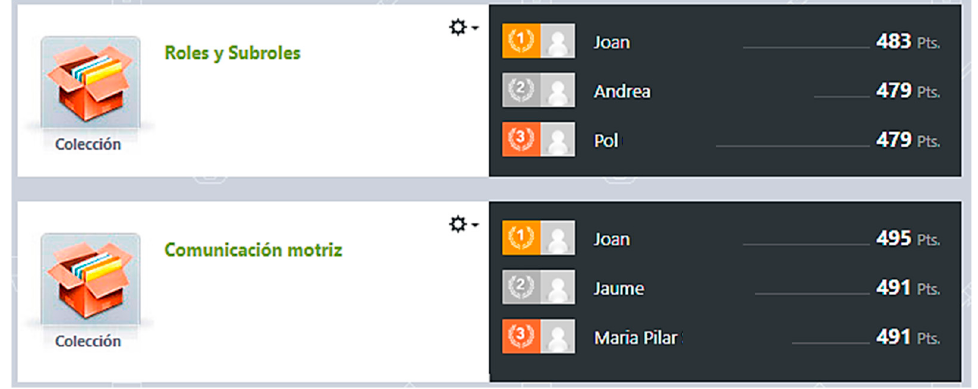
Figure 4. Competitive gamification dynamics with classification. EGc group.